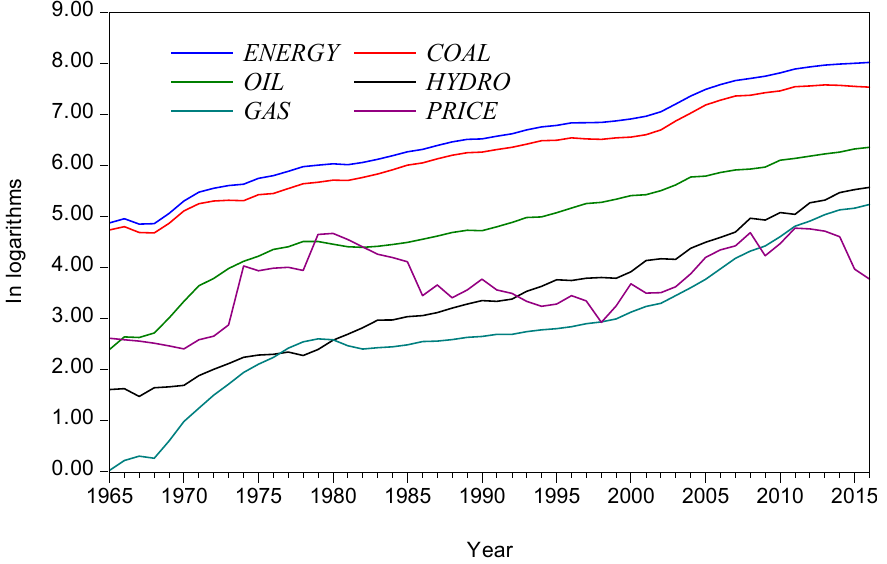
Figure 2. Real international crude oil prices and energy consumption in China.